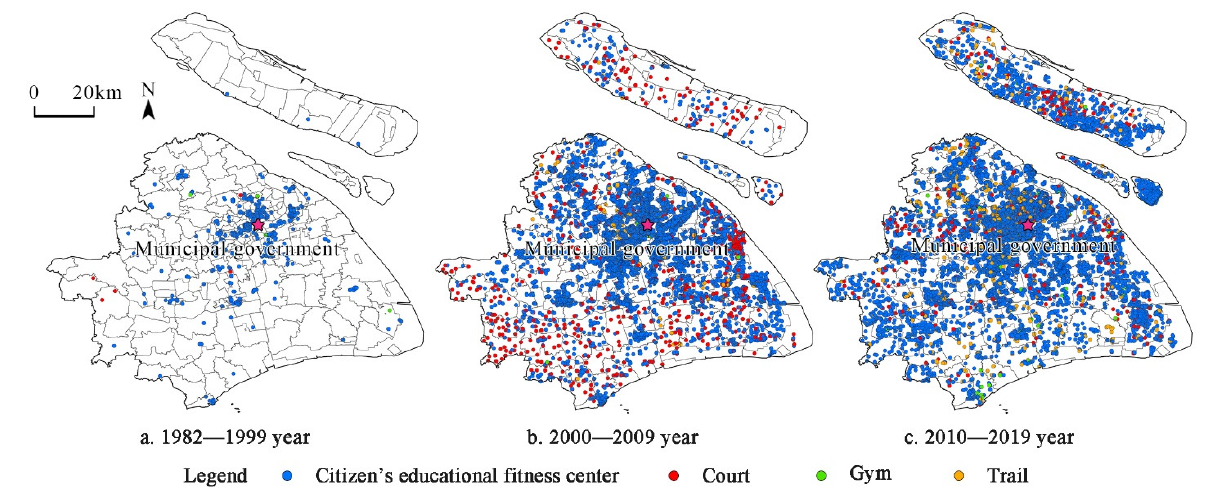
Figure 6. Evolution of the types of Shanghai’s community sports and fitness venues.